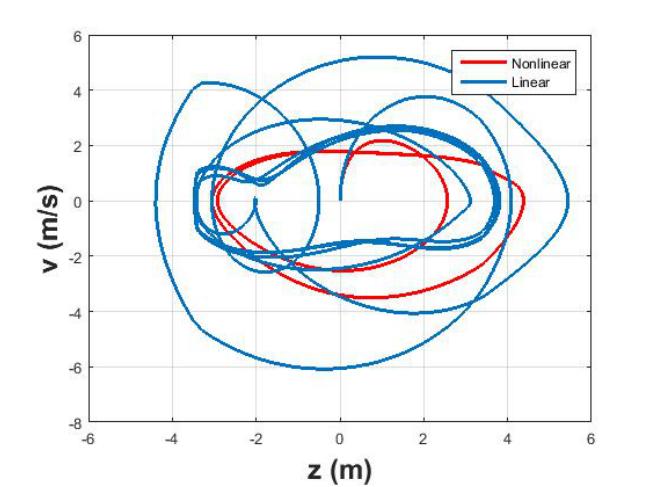
Figure 14. Hamiltonian surface for the linear WEC in a regular wave.